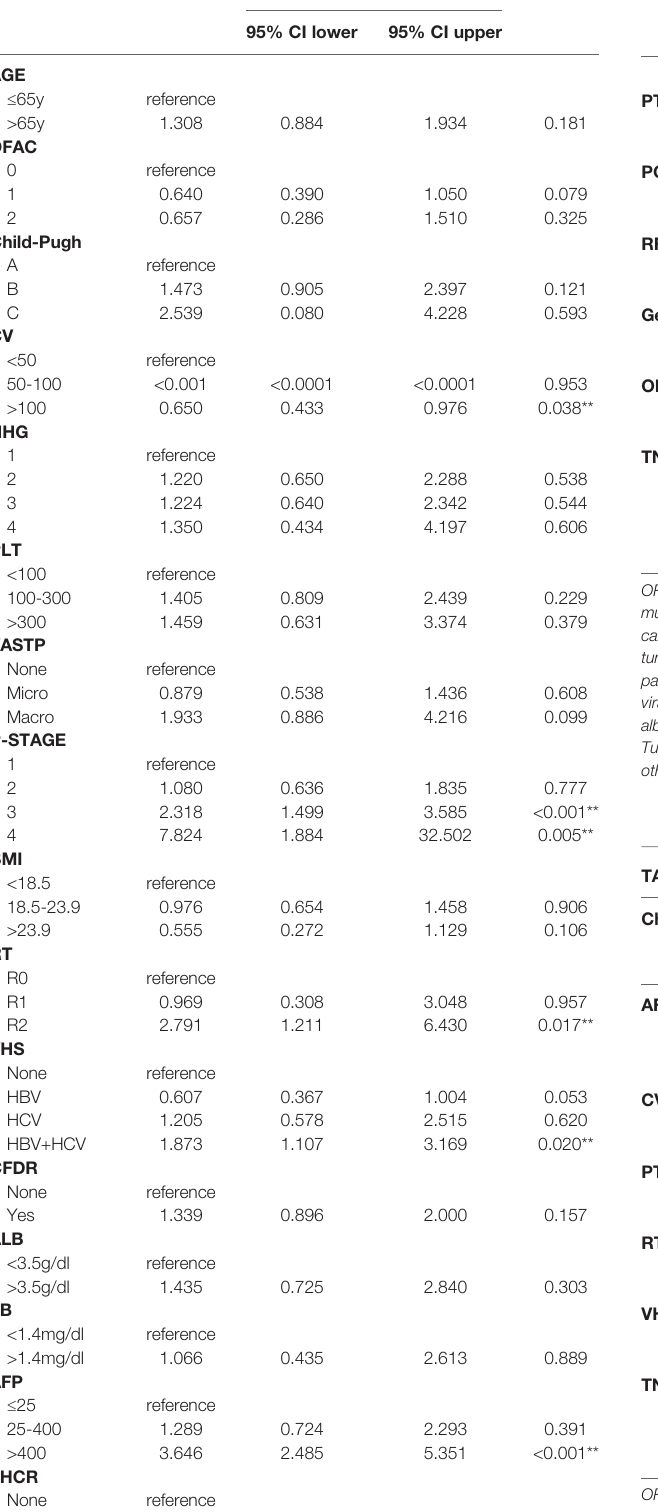
TABLE 2 | Continued Characteristics OR Univariable analysis